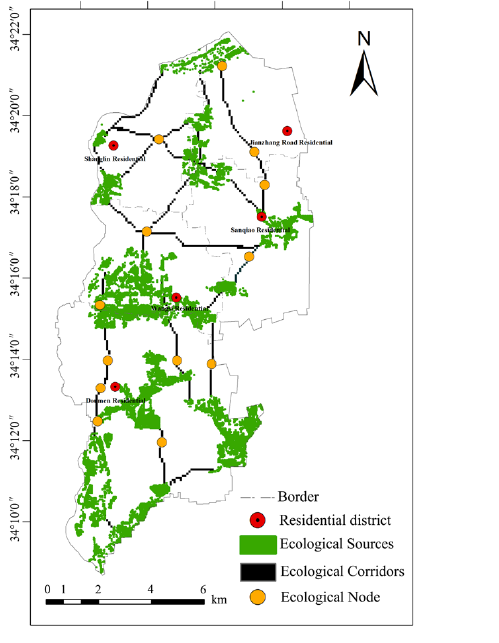
Table 5. Distribution of ecological nodes.